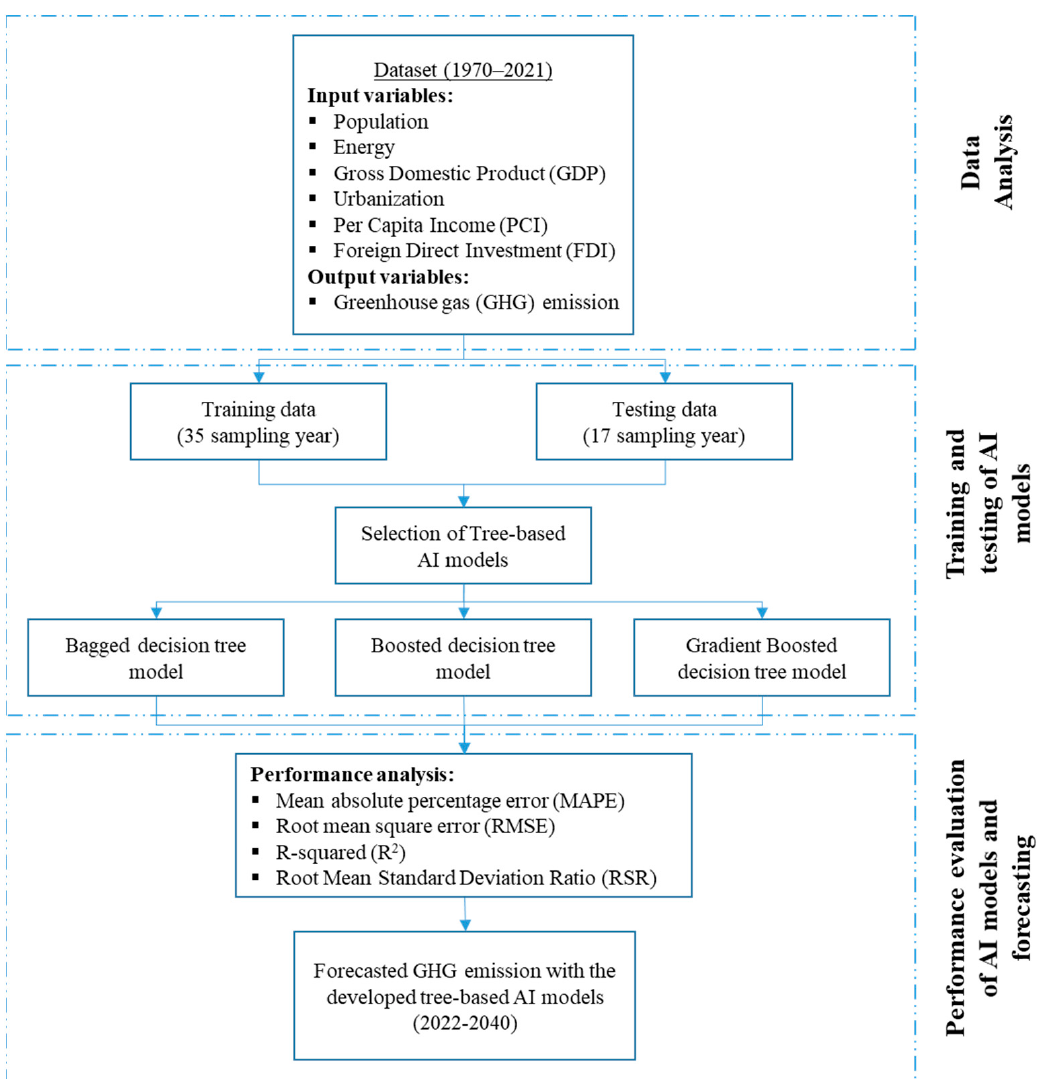
Figure 5. Structure of the proposed tree-based AI model.